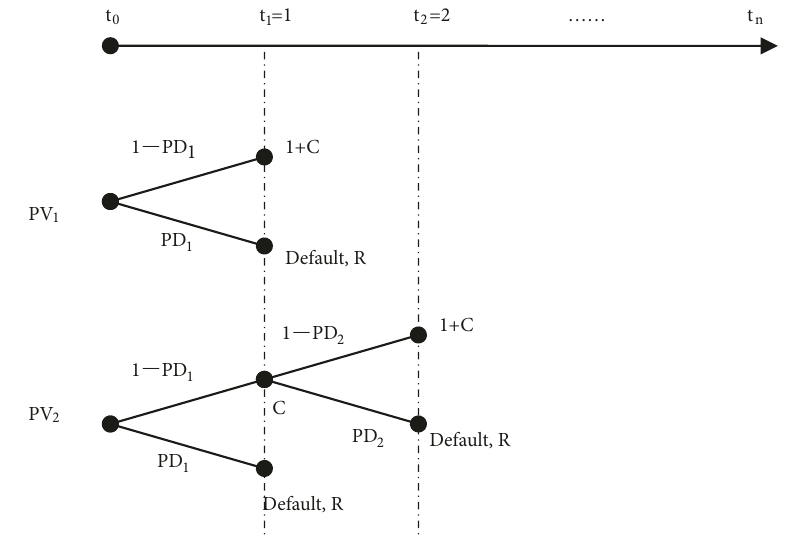
Figure 2: Binary tree-solution of default probability.